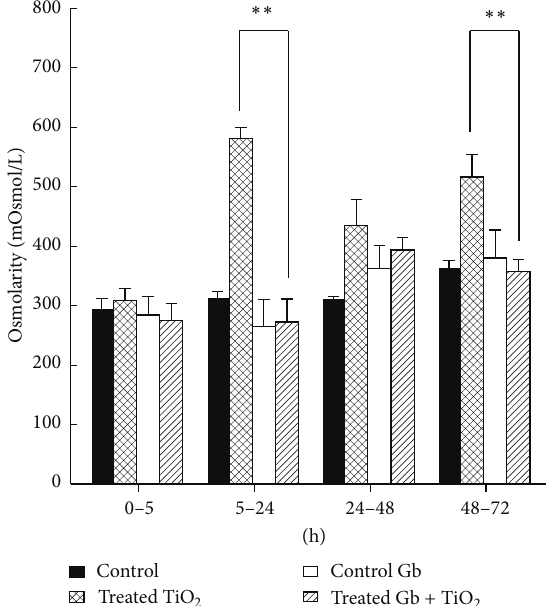
Figure 5: The effects of GbE on the renal effects of titanium dioxide in the urine osmolarity, at different time periods, compared with control, GbE, and TiO 2 -treated rats. The osmolarity is shown as mOsmoles/liter. The significance level is ∗∗ 𝑃 < 0.01